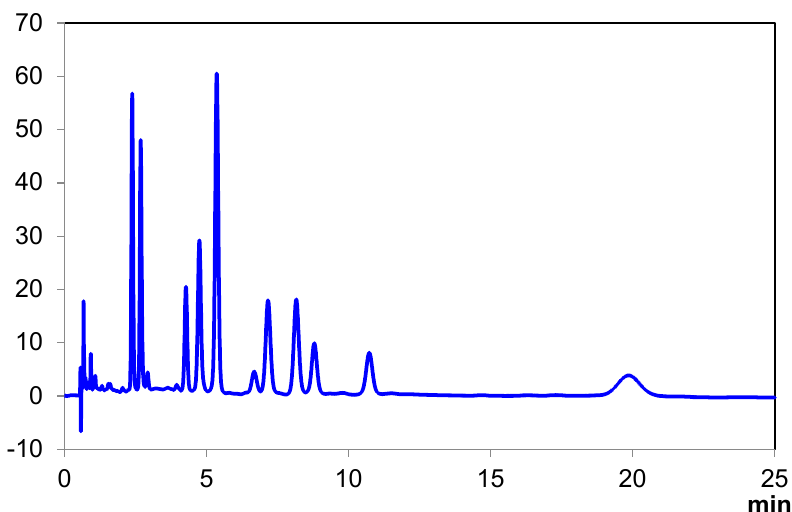
Figure 4. Ten-cannabinoid mixture separation under reversed-phase conditions with Chiralpak IG- U.